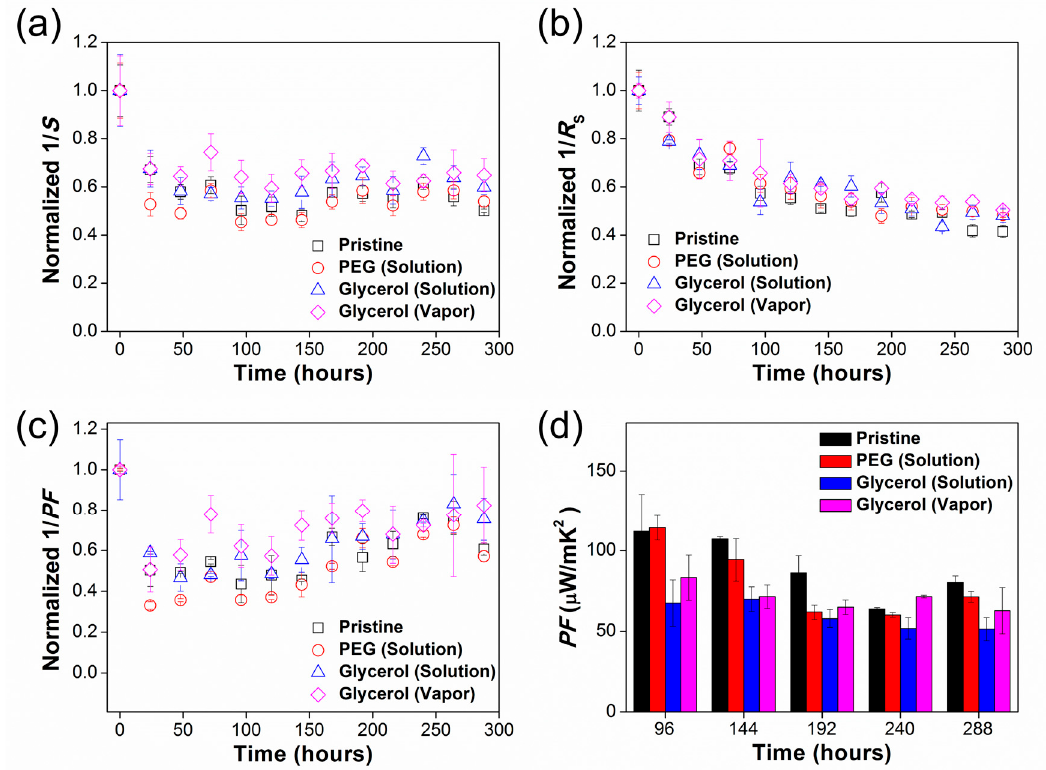
Figure 4. The normalized average value of ( a ) 1 / S, ( b ) 1 / R S , ( c ) 1 / PF, and ( d ) PF for Pristine, PEG solution-treated, PEG vapor-treated, glycerol solution-treated, and glycerol vapor-treated films as a function of storage time. The humidity condition is relative humidity of 95% and temperature of 27 °C.